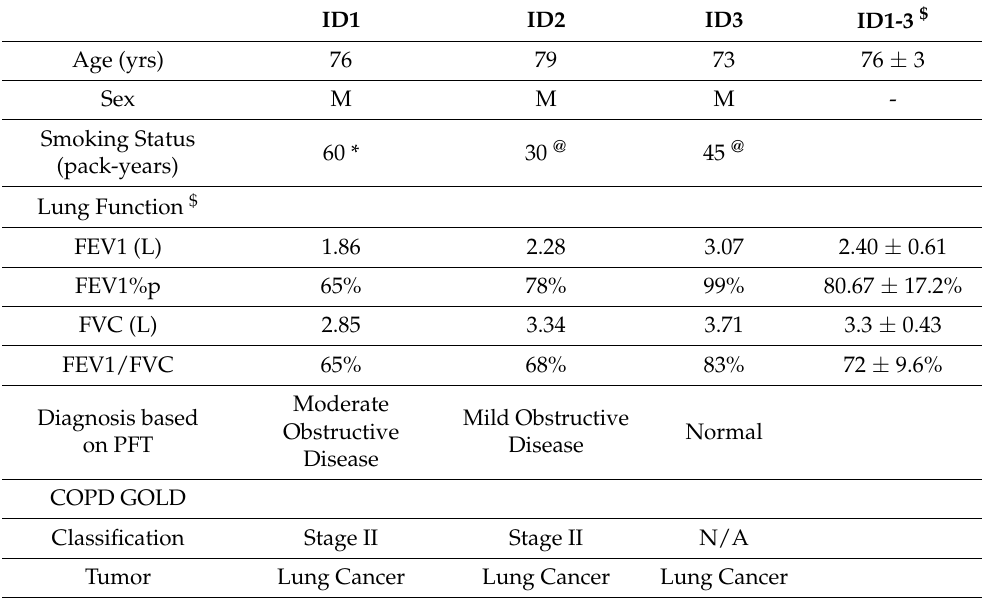
Table 2. Non-IPF Patient Demographics and